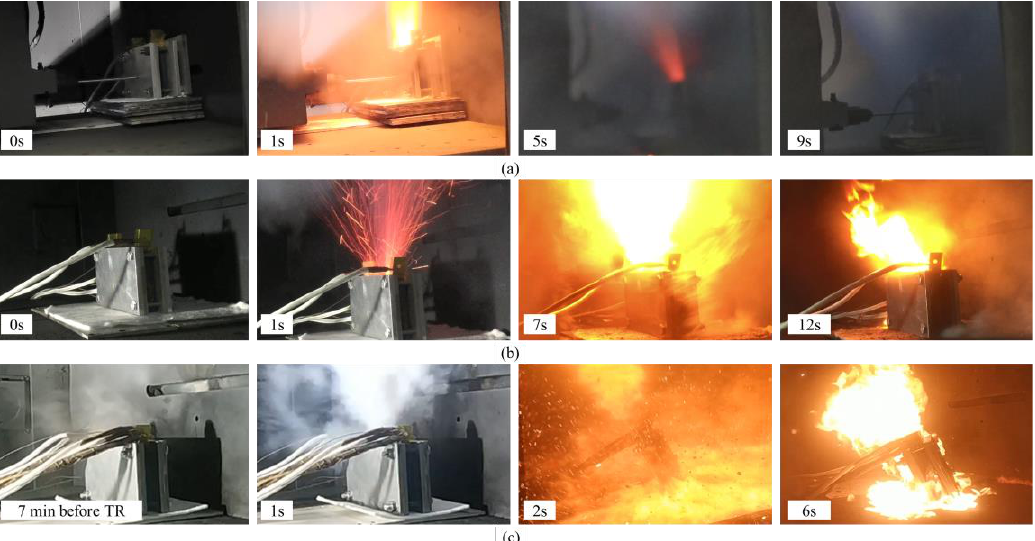
Figure 10. TR phenomena under different abuse test. ( a ) Nail penetration; ( b ) Side heating; ( c ) Overcharge.